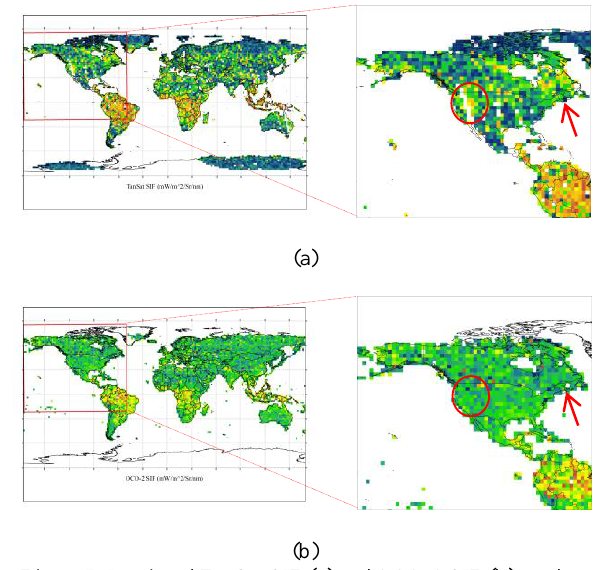
Figure 5. Retrieved TanSat SIF (a) and OCO-2 SIF (b) product distribution in North America in March 2018. (The difference in details is more obvious where the arrows point.)